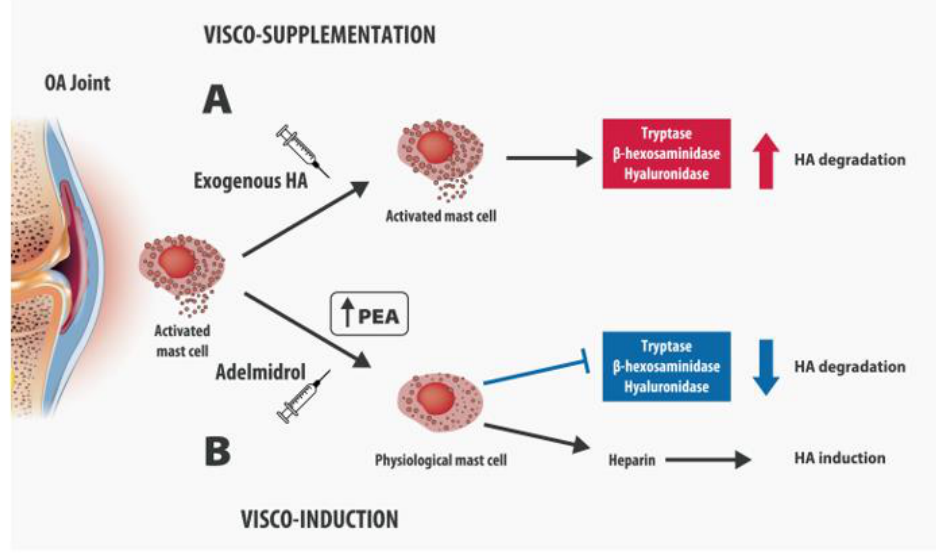
Figure 2. Visco-supplementation vs. Visco-induction. ( A ) Visco-supplementation: Exogenous HA is injected in the OA joints where activated MCs release tryptases, hyaluronidases, and β -hexosaminidases which in turn may accelerate HA degradation; ( B ) Visco-induction: Adelmidrol, by increasing endogenous PEA levels, downregulates MCs activation and shift them towards a physiological condition. Adelmidrol reduces the MCs degranulation, the release of lytic enzymes, and therefore the HA degradation, normalizing the physiological release of heparin, a HA precursor.